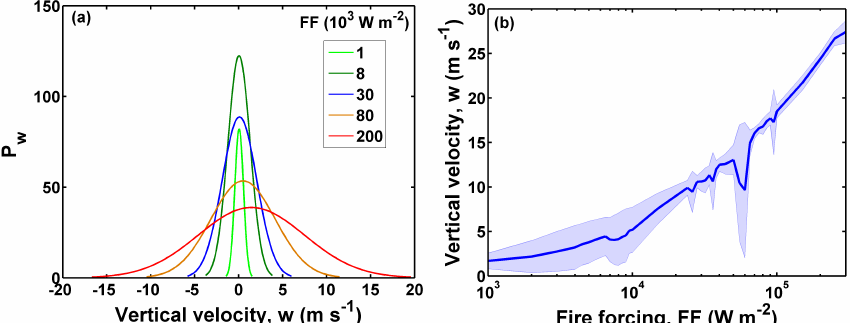
Figure 4. Probability distribution function of vertical velocities ( w ) at cloud base layer under different fire forcing conditions (a) . Relationship between input fire forcing (FF) and induced vertical velocity ( w ) at cloud base (b) . The aerosol concentration is 1000cm − 3 . The shaded area represents the variability of estimation ( ± 0.5 σ ).